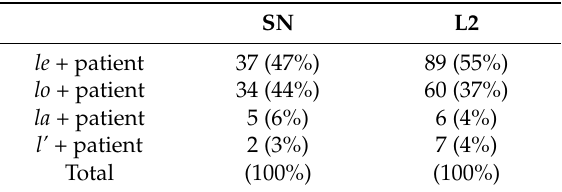
Table 9. Clitics according to thematic role